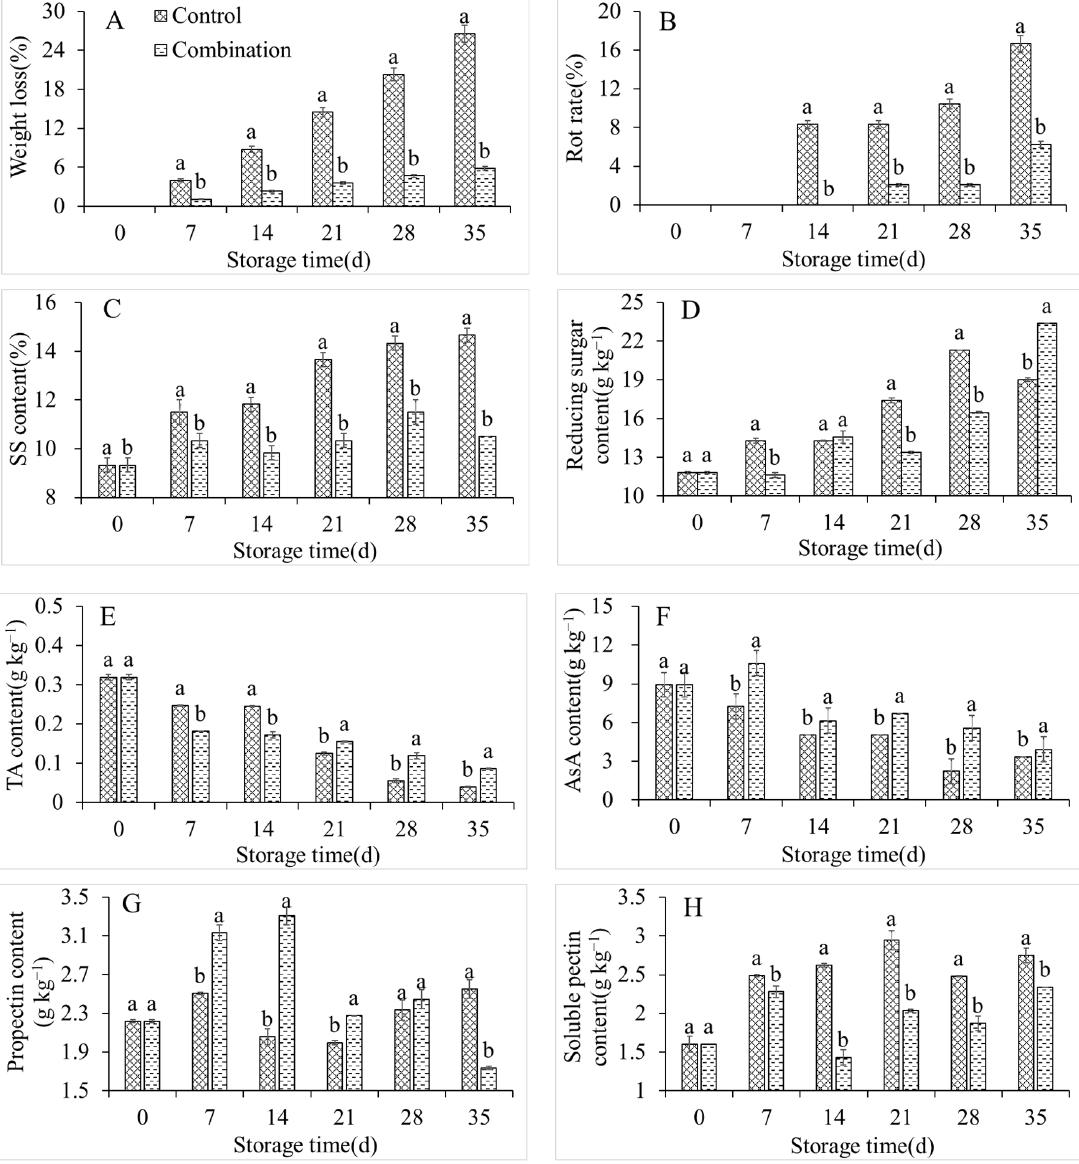
Figure 2. Weight lost ( A ), rot rate ( B ), SSC ( C ), reducing sugar ( D ), TA ( E ), AsA ( F ), propectin ( G ), and soluble pectin ( H ) contents of peaches during storage at 5 °C. Vertical bars indicate the standard errors of three replications. Different lowercase letters at same storage time points are significantly different ( p < 0.05).